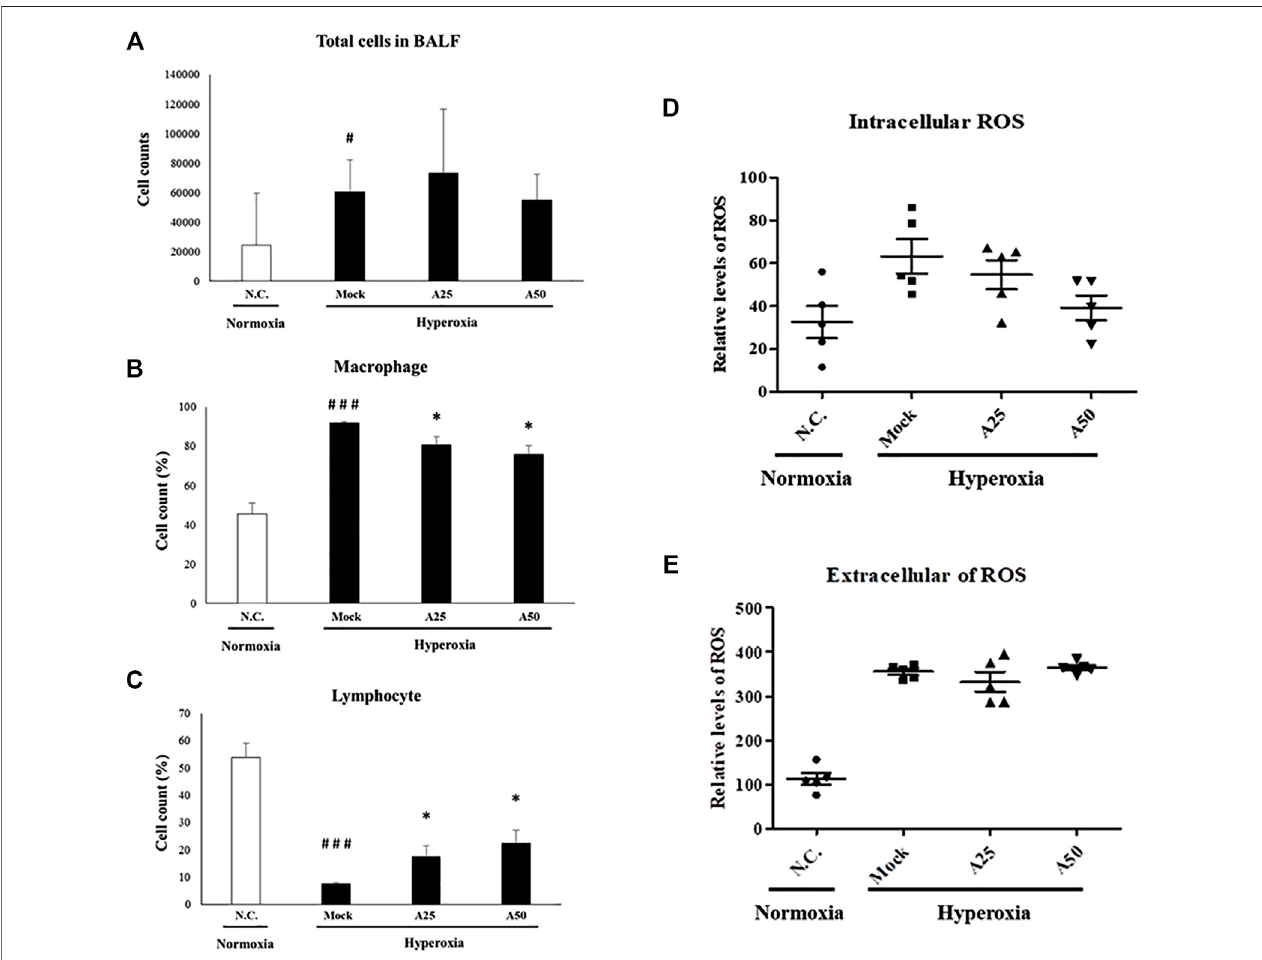
FIGURE 3 | Therapeutic ef fi cacy of aspirin against acute lung injury in mice (A) Total cells in the bronchoalveolar lavage fl uid (BALF) from NF- κ B-luciferase +/+ transgenicmiceexposedtohyperoxia (B) Thepercentageofmacrophagesamongtotalcells (C) Thepercentage oflymphocytesamongtotalcells (D) Thegenerationof intracellular reactive oxygen species (ROS) in bronchoalveolar lavage fl uid (BALF) from NF- κ B-luciferase +/+ transgenic mice exposed to hyperoxia (E) The generation of extracellular ROS in bronchoalveolar lavage fl uid (BALF) from NF- κ B-luciferase +/+ transgenic mice exposed to hyperoxia. The values are reported as the means ± SEM( n (cid:1) 6micepergroup). # p < 0.05and ### p < 0.001comparedwiththeN.C.group;* p <